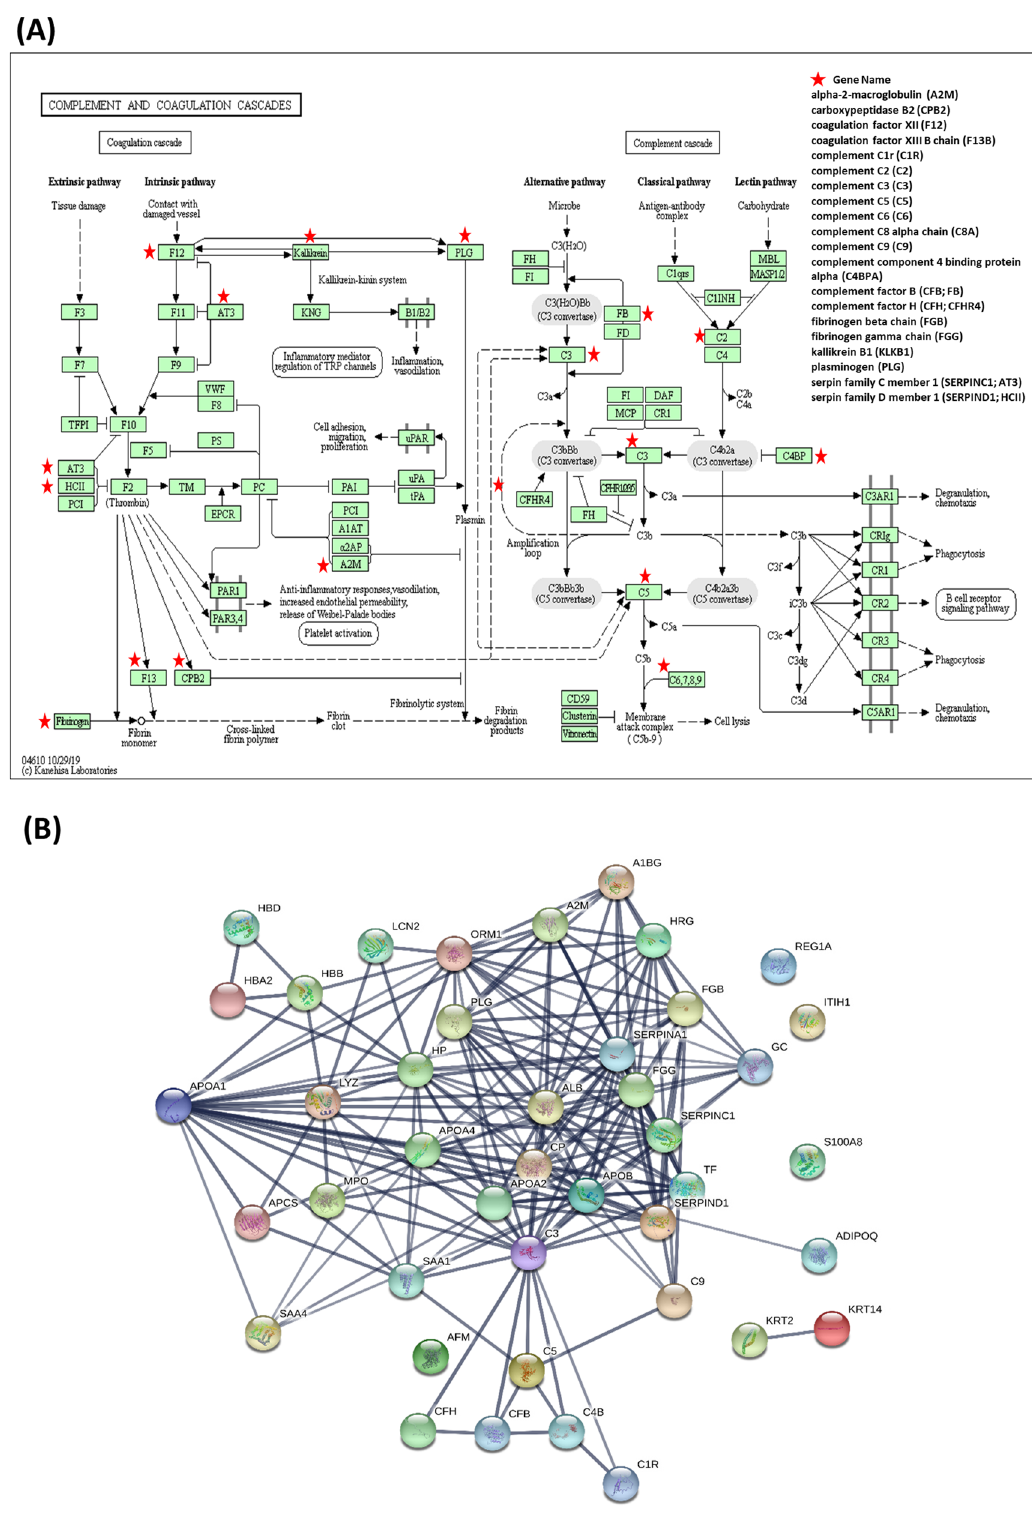
Figure 3. Biological process network analysis of differentially regulated urine proteins in KA. ( A ) KEGG pathway map for the complement and coagulation cascades identified as the top pathway enriched from a proportion of differentially expressed proteins (protein count = 20, denoted by asterisks). ( B ) Protein–protein interaction networks for 46 fibrosis-related proteins analyzed using STRING (PPI enrichment p-value < 10e−16, average local clustering coefficient of 0.583). Line thickness indicates the strength of data